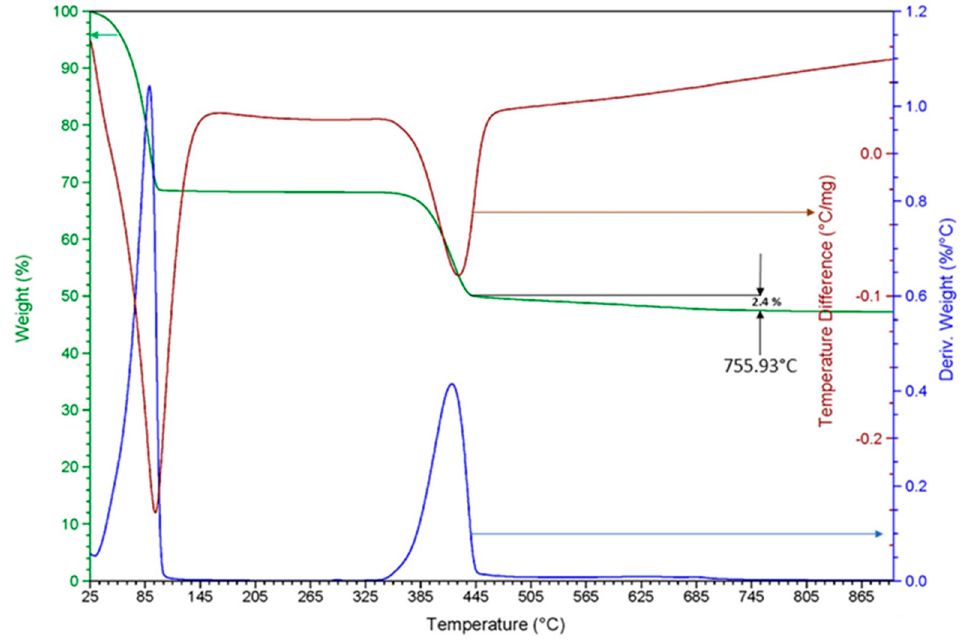
Figure 2. Results of the thermogravimetric and differential thermal analysis performed on brucite.